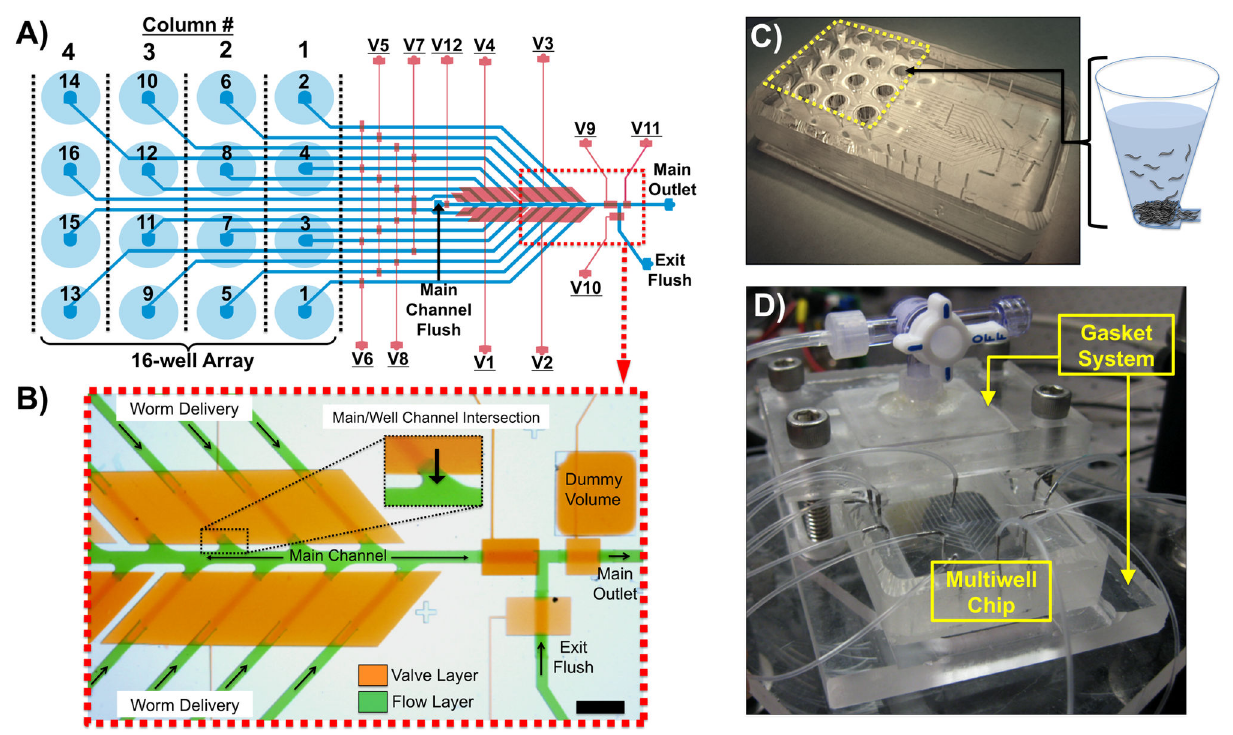
Figure 1. Population Delivery Chip design. A) A schematic of the device indicating the flow layer (blue) and control valve layer (red). There are 16 on-chip wells arranged in a 96-well plate format for initial loading of different worm populations. Columns and wells of the array are numbered according to order of delivery. Valves V1-V8 are multiplexer control valves and V9-V12 control flow in the main channel. B) An image of the device with its microfluidic channels loaded with food coloring dye, showing the flow layer (green) and control valve layer (orange) (scale bar ~1mm). C) A macro-scale view of the device with the 16-well array indicated by the yellow dashed lines and a schematic of worms loaded into one of the conical wells. D) A macro-scale view of the entire chip/ gasket system with pressurized input lines in the experimental